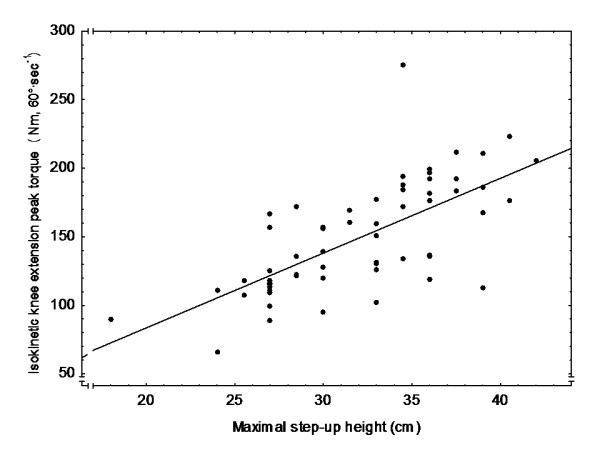
Correlation between maximal step-up height and quadriceps strength. Relation between the maximal step-up height (MSH, cm) and the quadriceps strength (isokinetic knee extension peak torque, IKEPT, N·m, 60°·sec-1) at occasion 3. Values for step-up height and quadriceps strength are calculated as the mean of the right and left leg.